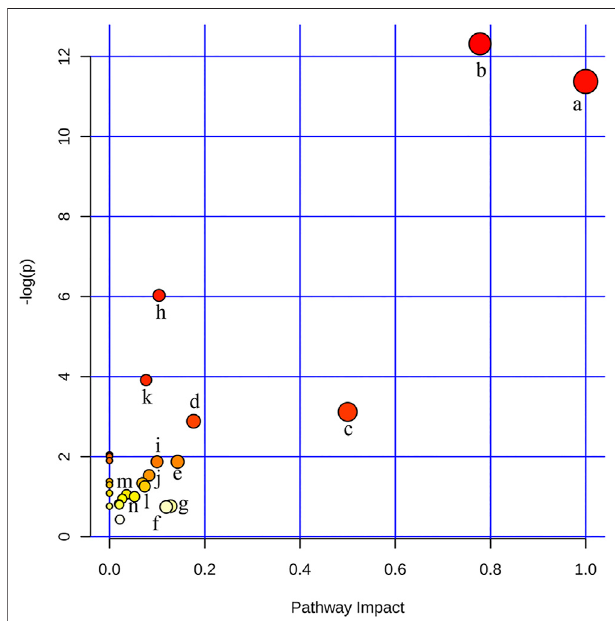
FIGURE 3 | Disturbed pathways in response to hyperlipidemia and AEE treatment in hamster. The x -axis was the pathway impact value calculated from pathway topological analysis, and the y -axis was the -log (p) value obtained from pathway enrichment analysis. a, Phenylalanine, tyrosine, andtryptophanbiosynthesis;b,Phenylalaninemetabolism;c,Ubiquinoneand other terpenoid-quinone biosynthesis; d, Glutathione metabolism; e, Valine, leucine, and isoleucine biosynthesis; f, Tryptophan metabolism; g, Tyrosine metabolism; h, Aminoacyl-tRNA biosynthesis; i, Ribo fl avin metabolism; j, Glyoxylate and dicarboxylate metabolism; k, Pantothenate and CoA biosynthesis; l, Pyruvate metabolism; m, Citrate cycle (TCA cycle); n, Glycerophospholipid metabolism.